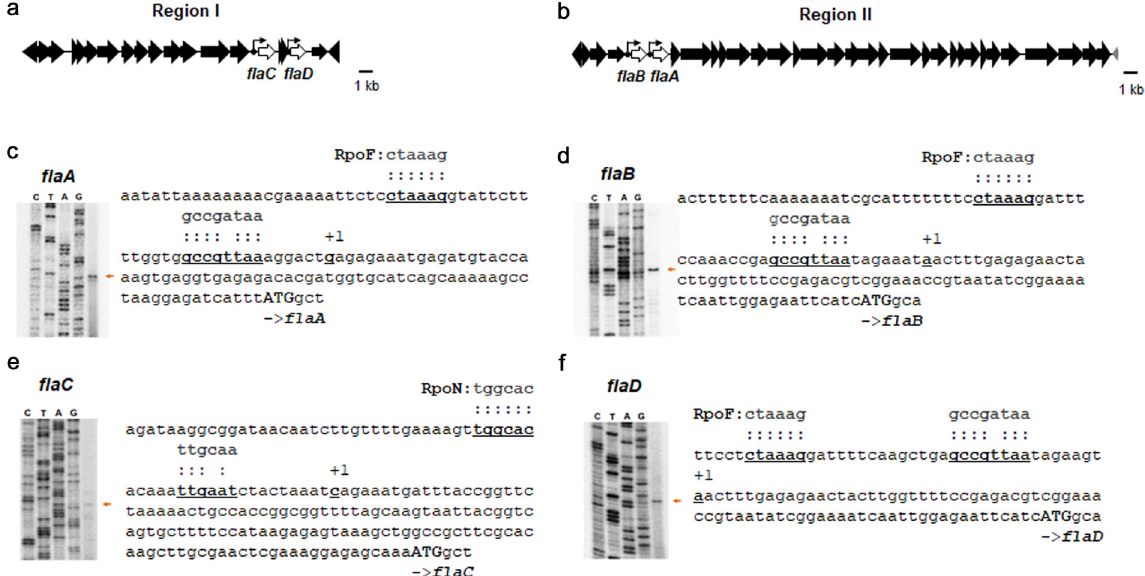
Fig. 9 Transcription of fl aA , fl aB , fl aC , and fl aD genes. a , b Gene clusters for fl agellar assembly. V. vulni fi cus MO6-24/O genomes include four fl agellin genes 12 , fl aC (VVM06_02255) and fl aD (VVM06_02252) at region I and fl aB (VVM06_00808) and fl aA (VVM06_00809) at region II. c – f Identi fi cation of transcription initiation sites (TIS) and promoters. Primer-extension experiments using a primer speci fi c to each fl a gene (Supplementary Table 2) revealed TIS and the promoters of fl aA ( c ), fl aB ( d ), fl aC ( e ), and fl aD ( f ). Lane C, T, A, and G represent the nucleotide sequencing ladders of the upstream region for each gene. An arrow denotes the cDNA band indicating TIS. TIS (designated with + 1) and its promoter (underlined and aligned with the consensus sequences for RpoN or RpoF 68,69 ) were indicated in nucleotide sequences upstream of the initiation codon (ATG) of each